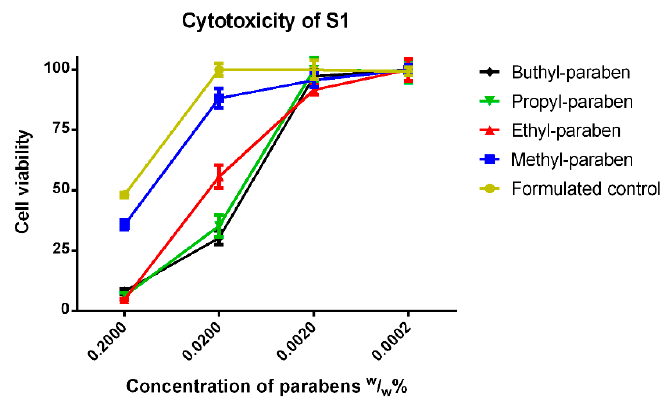
Figure 6. Cytotoxicity of the first formulated system (S1) consisting of 30% ( v / v ) glycerol and 0.002% ( v / v ) Polysorbate 20 measured by MTT-assay. Cell viability expressed as the percentage of the absorbance of the untreated control cells. Data expressed as mean ± SEM, n = 12. Cell viability of the samples at 0.2000; 0.0200; 0.0020; 0.0002 ( w / w )% concentrations of different formulations containing parabens: formulated control: 48% ± 1.1%; 100% ± 2.7%; 100% ± 4%; 98% ± 1.8%; formulated MP: 36% ± 1.9%; 88% ± 4.1%; 96% ± 2.9%; 100% ± 2.1%; formulated EP: 5% ± 0.3%; 56% ± 2%; 92% ±